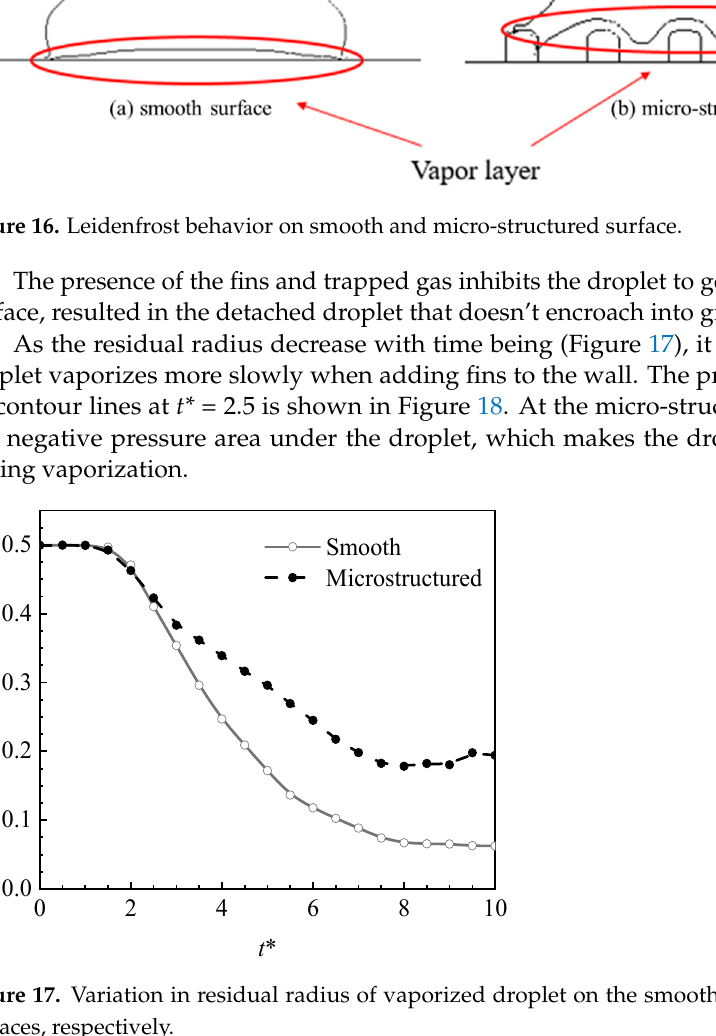
Figure 18. Pressure field at t* = 2.5. At t* = 5, the temperature of the smooth surface is significantly higher than that of the micro-structured surface, and the temperature curve shows violent fluctuation as shown in Figure 19. The gas produced during droplet vaporization is responsible for fluc- tuation due to a lower thermal conductivity than that of LN 2 . The temperature of the area covered by gas shows a high level while the temperature of the wall that is exposed to LN 2 shows a significant drop. The overall temperature curve shows a trend of high on both sides and low in the middle, confirming the fact that cooling capacity is transferred to both sides from the area where the droplet falls and hits.